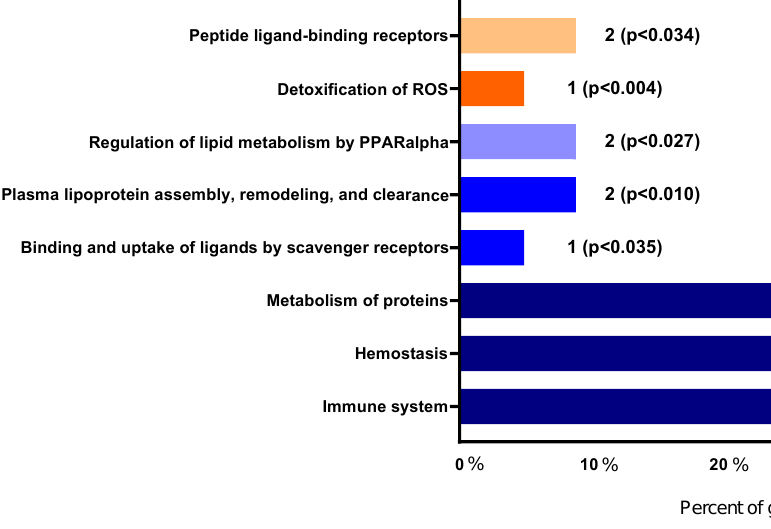
Figure 7. Functional significance of the identified proteins on biochemical pathways according to Reactome database. Reactome